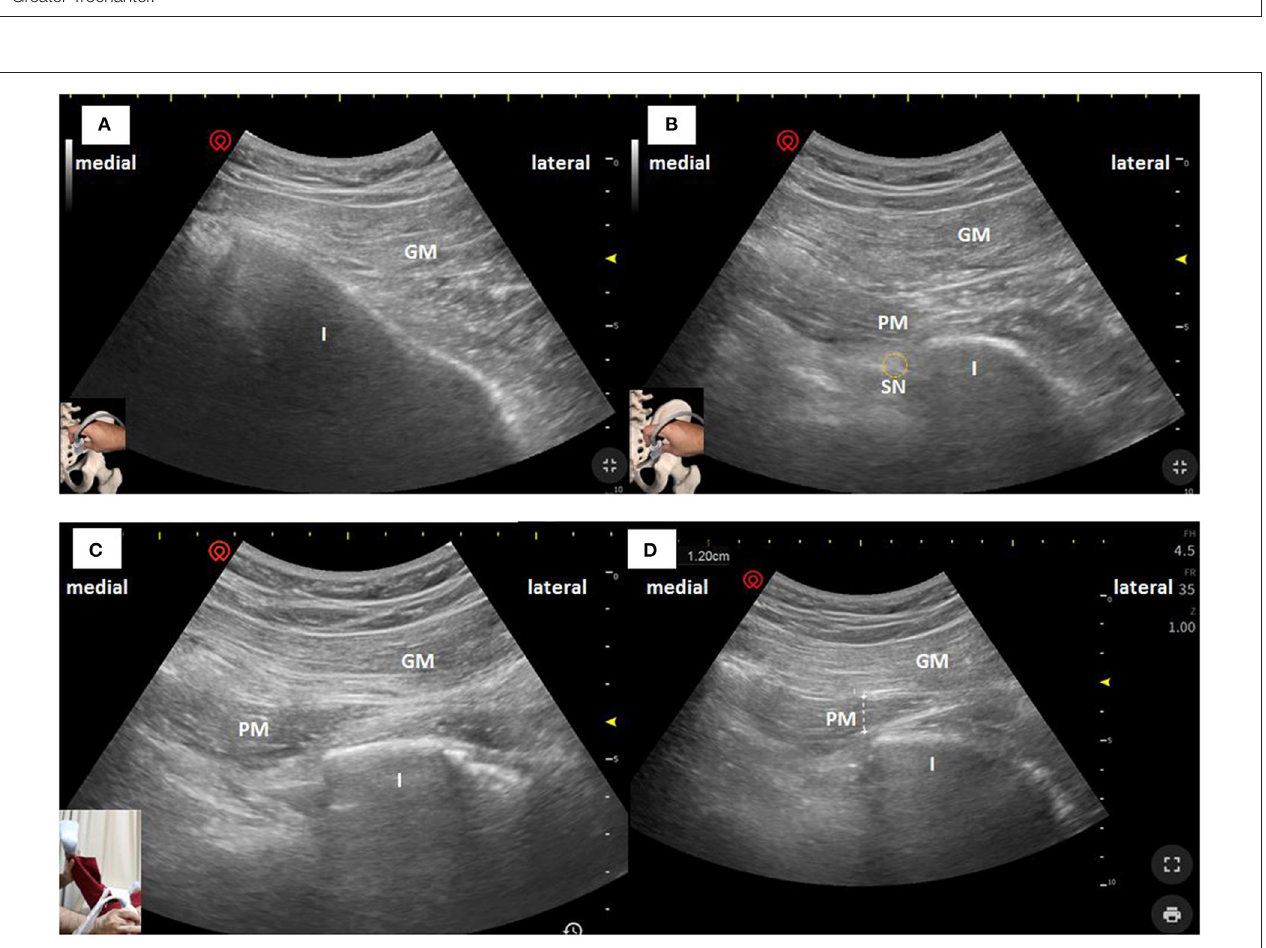
FIGURE 2 | Ultrasonographic images of the PM in the longitudinal plane obtained with a curvilinear transducer at 2.5–5 MHz. The PM can be seen deeper to the GM and passing laterally toward the GT. (A) US image when superficial images above conducted. (B) US image when the clinician moved the probe inferiorly. (C) US image when the patient’s leg was maximal abducted. (D) PM thickness was measured in the medial part of the tip of the ischium, which was parallel to the longitudinal plane at the sciatic notch with the patient’s leg was abducted 45 ◦ . I, Ischium; GM, Gluteus Maximus; PM, Piriformis Muscle; SN, Sciatic Nerve.